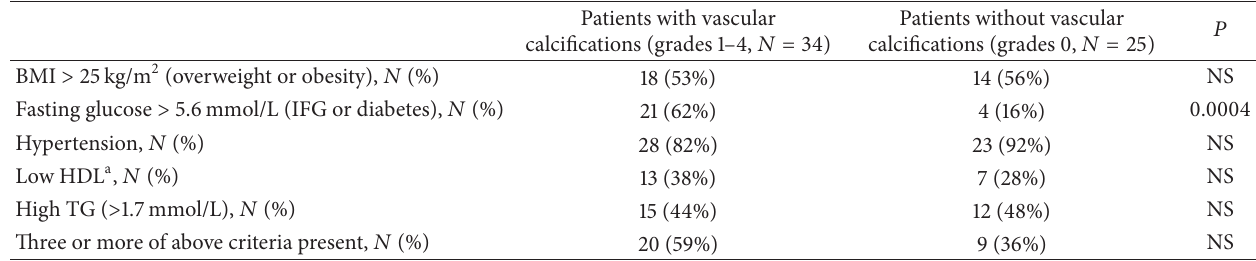
Patients with vascular Patients without vascular 𝑃 calcifications (grades 1–4, 𝑁 = 34 ) calcifications (grades 0, 𝑁 = 25 )